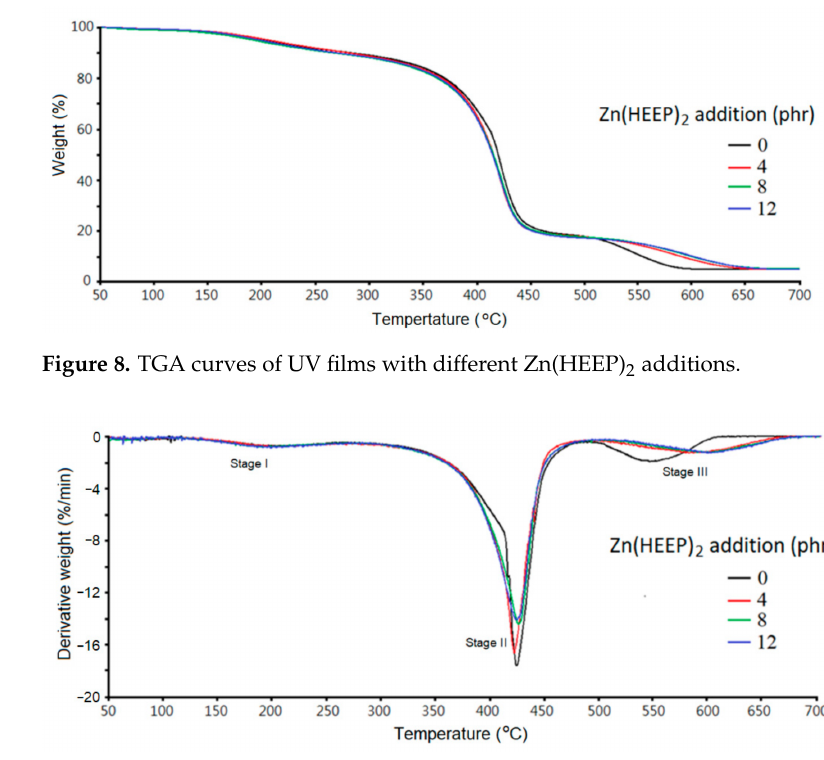
Figure 9. The DTG curves of UV films with different Zn(HEEP) 2 additions. Table 5. The pyrolysis parameters of UV films with different Zn(HEEP) 2